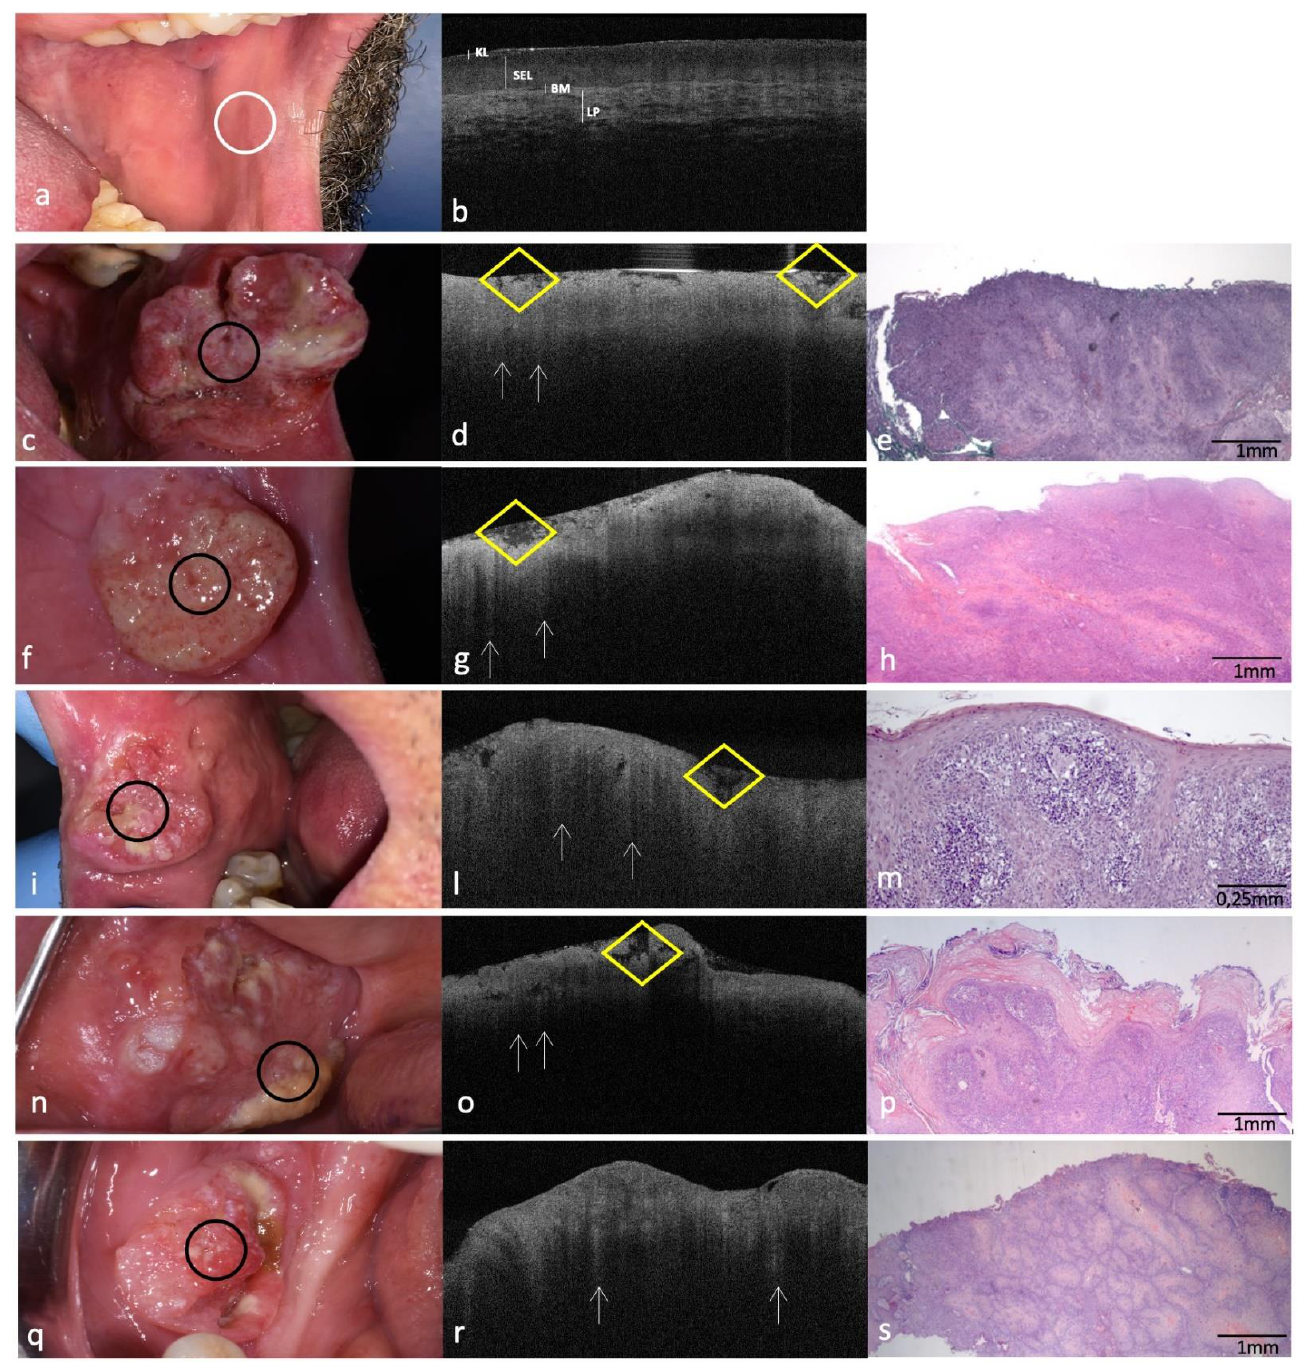
Figure 5. Clinical, OCT and histopathology images of OSCCs sited on buccal mucosa compared with the same healthy site (code C06.0). ( a , b ): Clinical and OCT images of healthy buccal mucosa; the site of in vivo OCT evaluation is indicated with a white circle ( c – i , l – s ): Clinical, OCT and histopatho- logical images (H-E stain; original magnification × 25 in ( e , h , p , s ); original magnification × 100 in ( m )) of five OSCCs on buccal mucosa; the site of in vivo OCT evaluation is indicated with a black circle; “icicle-like” structures are indicated with white arrows; fibrin deposits are indicated with a yellow rhombus. KL–Keratinized layer; SEL—Stratified Epithelial Layer; BM—Basement Membrane; LP — Lamina Propria.